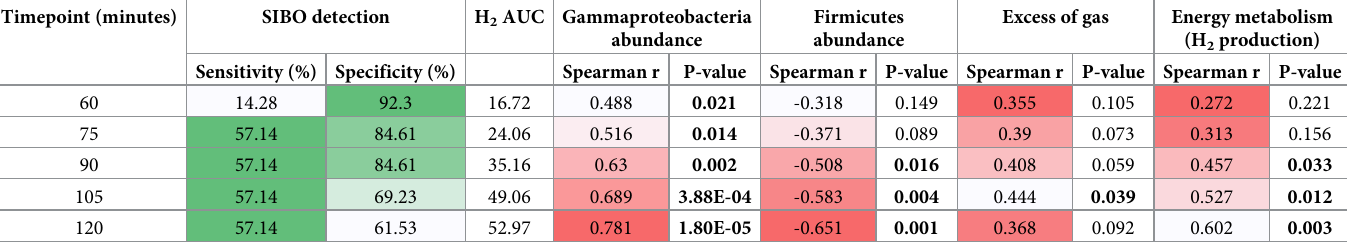
Significant changes (P < 0.05) are indicated in bold. Darker green color represents greater sensitivity and specificity. Darker red color represents higher